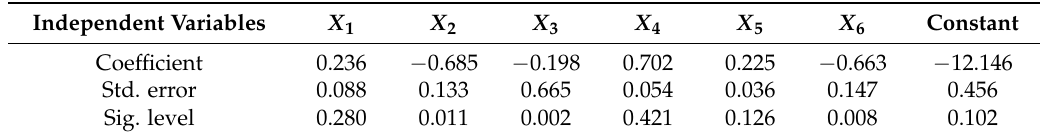
Table 4. Model summaries of multiple regressions for prediction of extraction yield of